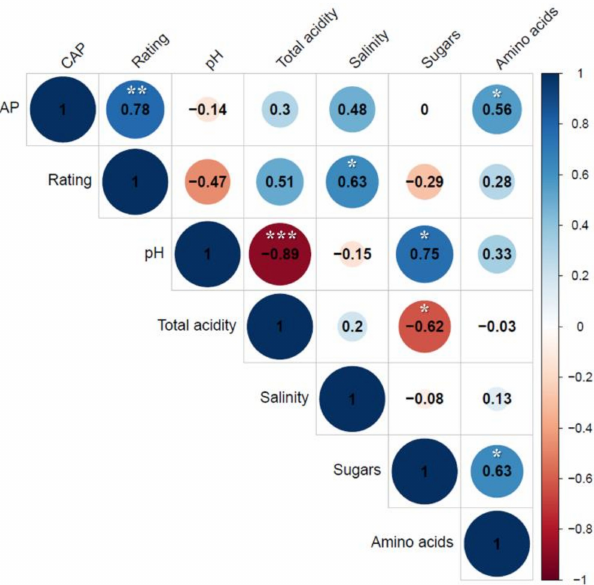
Figure 3. Correlation coefficient matrix of sensory spiciness evaluation and physicochemical pa- rameters in commercial kimchi samples. Positive coefficients are represented by blue circles, which indicate a direct relationship between variables in the matrix, and negative coefficients are shown as red circles, which reflect an inverse relationship. * p ≤ 0.05, ** p ≤ 0.01, *** p ≤